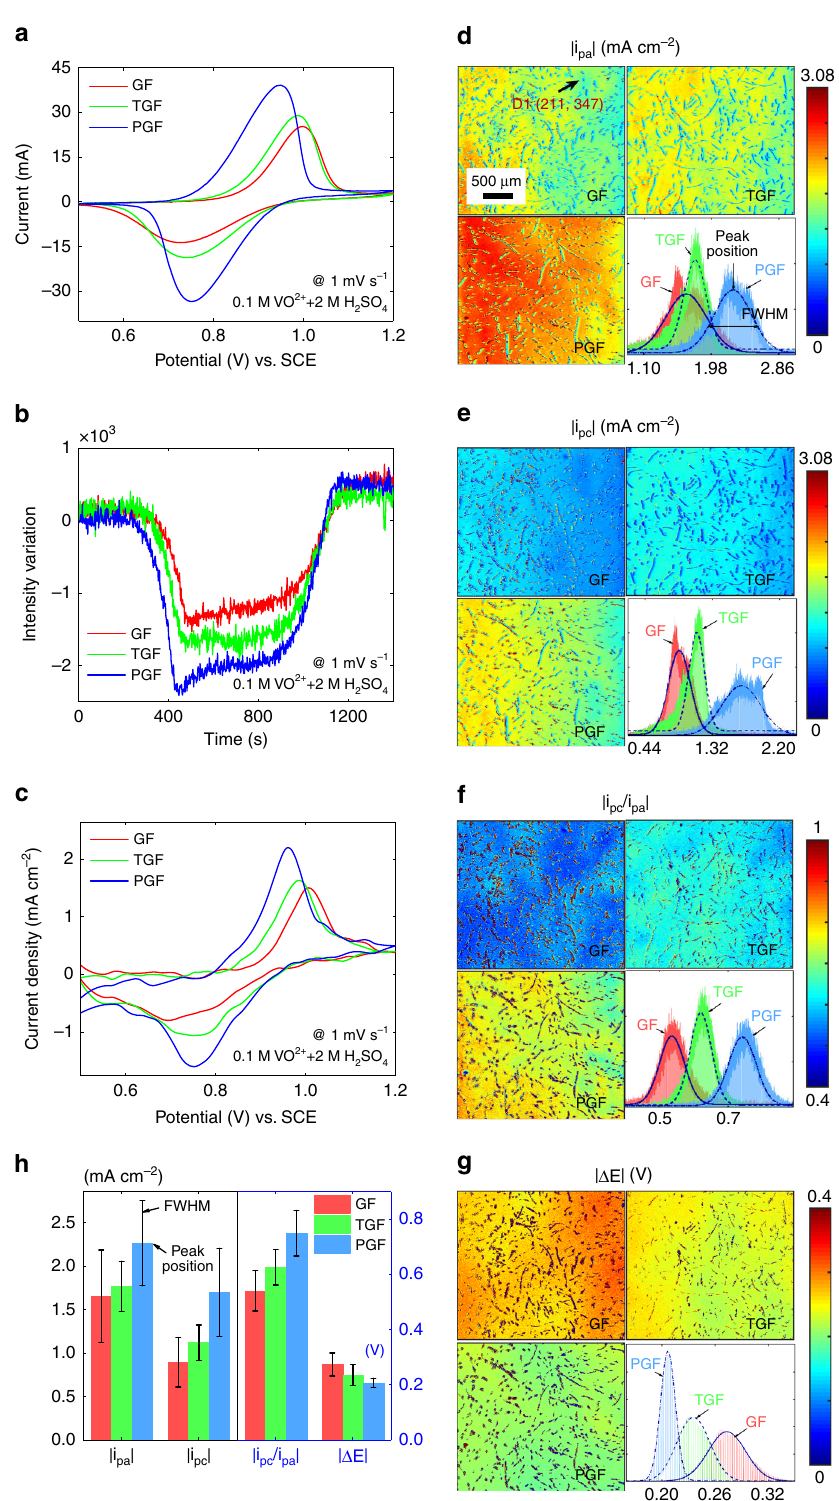
Fig. 3 Activity and reversibility distribution comparison of three electrodes. a CV curves of the GF, TGF and PGF in the positive electrolyte of 0.1 M VO 2 + and 2 M H 2 SO 4 at a scan rate of 1 mV s − 1 recorded by EW. b TIR intensity variations of the GF, TGF and PGF of point D1 (211, 347) recorded by the TIRi sensor. c CV curves by convolution calculation of the data in b . The mapping of the peak oxidation current densities | i pa | ( d ), the peak reduction current densities | i pc | ( e ), the ratio of two peaks | i pc / i pa | ( f ) and the peak potential separation value | Δ E | ( g ) of the GF, TGF, and PGF respectively and their distribution in the bottom right. h The peak position and FWHM (labeled in d ) comparison of | i pa |, | i pc |, | i pc / i pa | and | Δ E | from the distributions in the bottom right of ( d – g